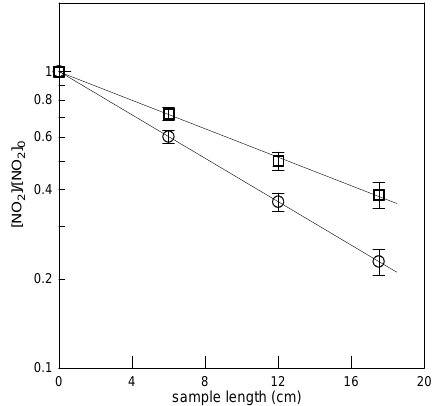
Fig. 2. Photolysis frequency of NO 2 ( J NO number of UV lamps switched on.